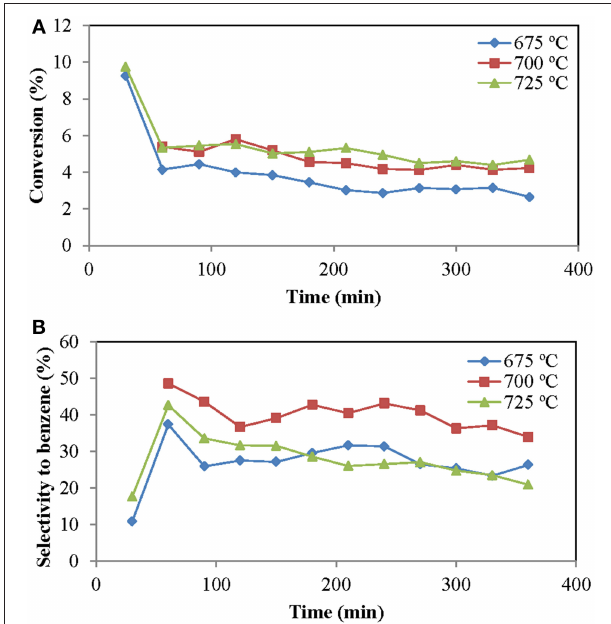
FIGURE 2 | Influence of temperature on methane aromatization reaction (time on stream): (A) Methane conversion, (B) Selectivity to benzene. Operating conditions: W cat = 12g, CH 4 :O 2 :N 2 = 70: 0.5:29.5; u rlowerzone = 2. Equilibrium conversion, considering only the methane to benzene reaction, is c.a. 9.8% at 675 ◦ C, 12% at 700 ◦ C and 14% at 725 ◦